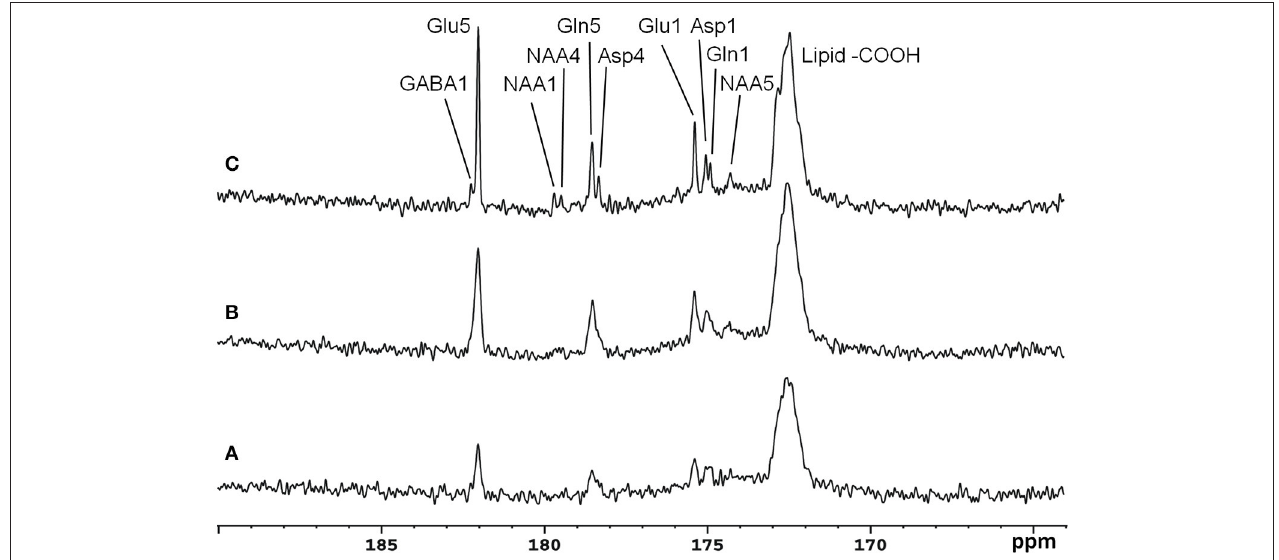
FIGURE 5 | Spectra from a healthy volunteer obtained at 7 Tesla under the following conditions: (A) with neither NOE nor decoupling; (B) with NOE only; and (C) with both NOE and decoupling. Using the peak amplitude of Glu C5 in condition (A) as a reference, the peak amplitude of Glu C5 was increased on average, by a factor of